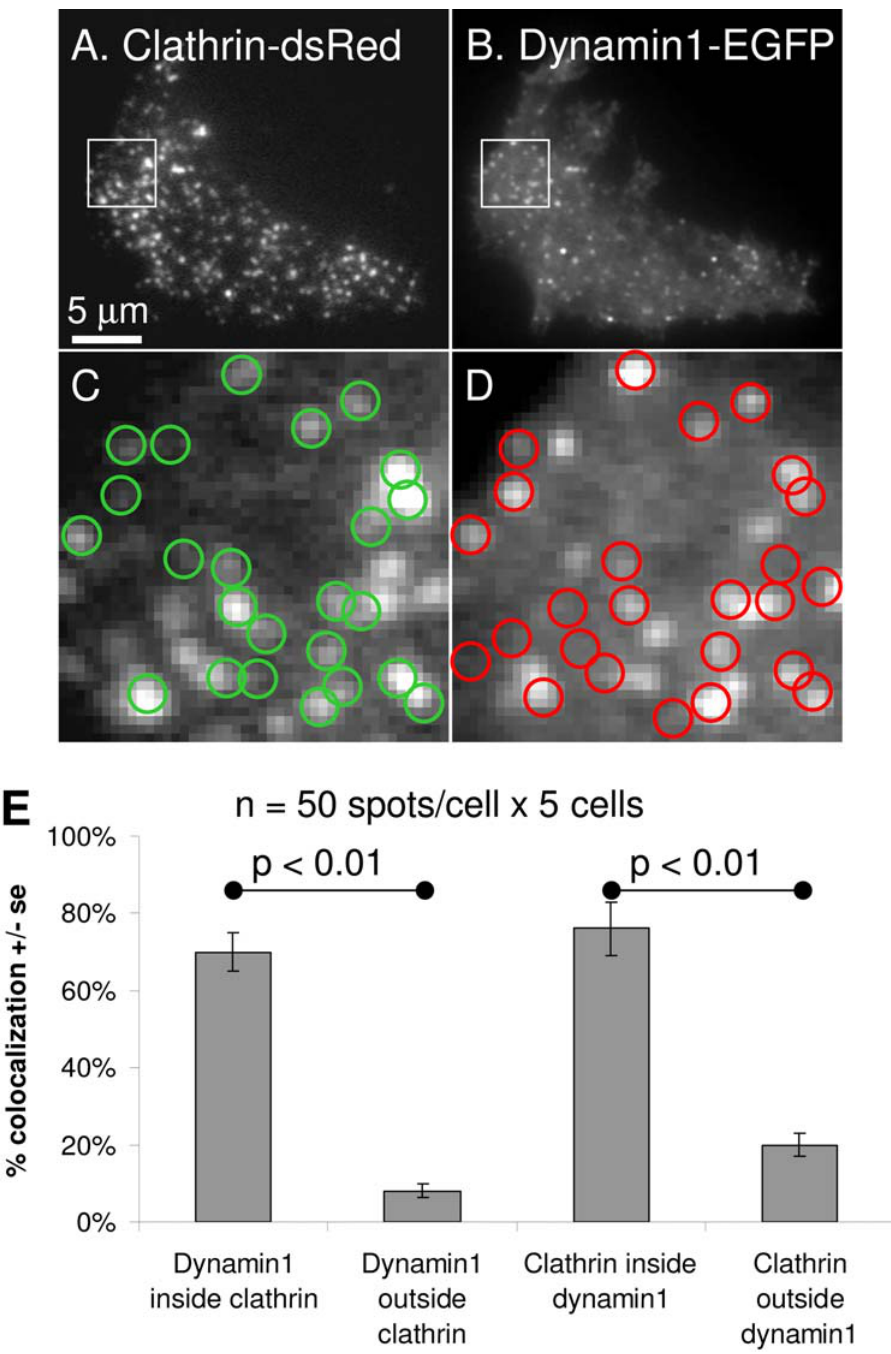
Figure 1. Co-localization of clathrin and dynamin1 in PC12 cells. PC12 cells co-transfected with clathrin-dsRed (A,C) and dynamin1-EGFP (B,D) were imaged by TIR-FM. Regions drawn around clathrin spots (A) were transferred to dynamin1 images (red circles in D). Regions drawn around dynamin1 spots (B) were transferred to clathrin images (green circles in C). 250 spots per group were evaluated to determine if clathrin and dynamin1 co-localize (E). Dynamin1 at sites of clathrin spots is significantly higher than dynamin1 outside clathrin spots. Clathrin corresponding to dynamin1 spots is significantly higher than dynamin1 outside clathrin spots.